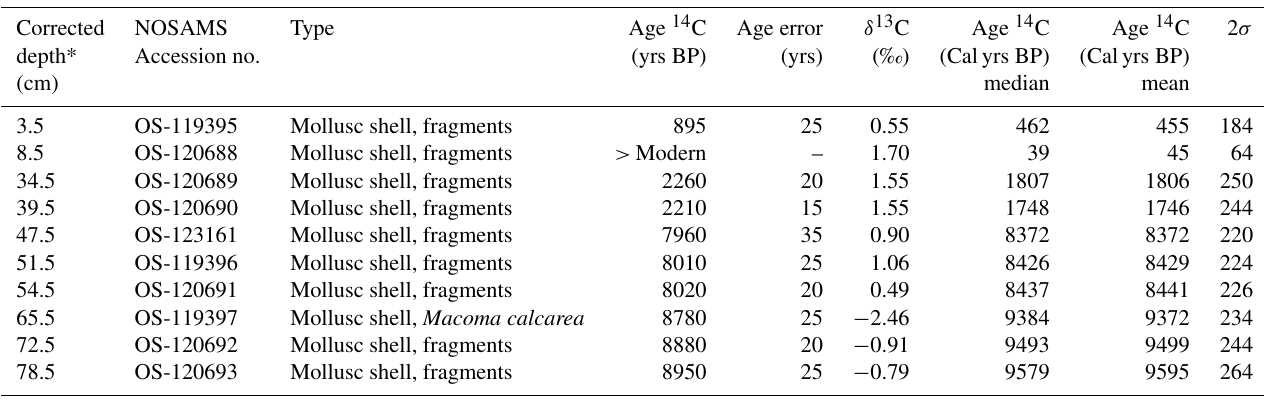
Table 1. Radiocarbon ( 14 C) ages of the mollusc shells retrieved from the sediment core GC58. The 14 C ages are shown in years BP with an age error (yrs) and as calibrated 14 C ages (calyrs BP) with 2 standard deviations ( ± 2 σ ) of the individual 14 C dates. The calibration curve used was Marine13 (Reimer et al., 2013) and a (cid:49)R value of 50 ± 100yrs (Bauch et al., 2001a). Also shown are the δ 13 C (‰) values of the mollusc